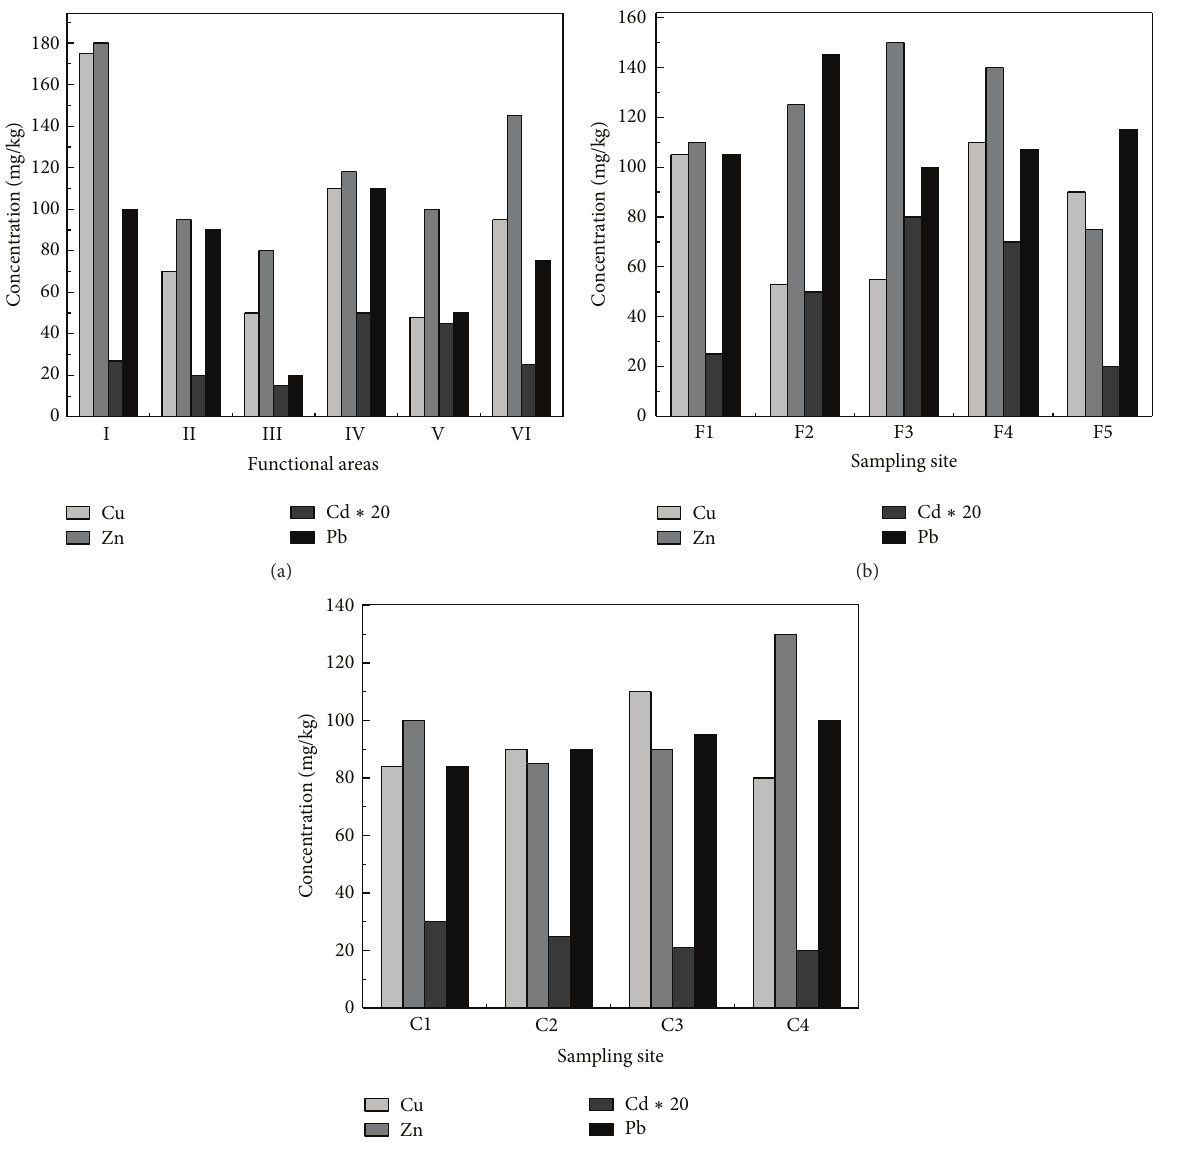
Figure 2: Metal concentrations of (a) six functional areas: (I) old residential area, (II) comprehensive area, (III) new residential area, (IV) pedestrian only commercial area, (V) educational area, and (VI) business area; (b) Fuwai Street; (c) Chegongzhuang